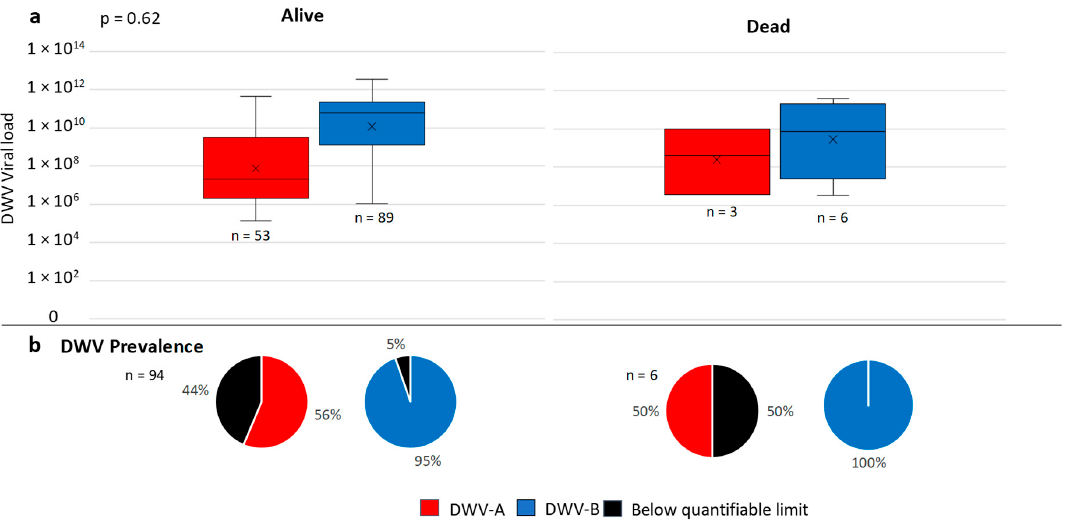
Figure 5. Box plots of viral load in DWV-A and -B RT-qPCR quantifiable English and Welsh colonies that survived the overwinter period and those that died ( a ). Pie charts show the percentage of DWV quantifiable colonies and those that tested positive below the limit of quantification ( b ).